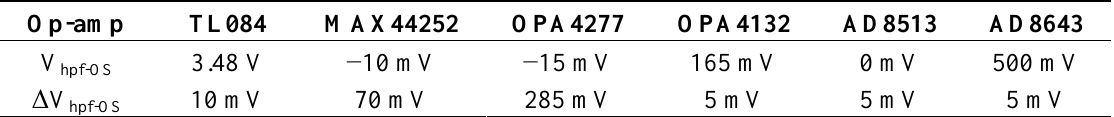
Table 4. Output DC offset measured at the v HPF in Figure 4.